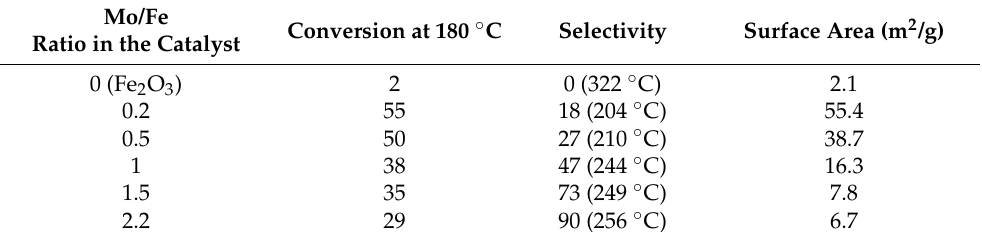
Table 4. Activity, selectivity, and specific surface area of the iron molybdate catalyst under various Mo/Fe ratios